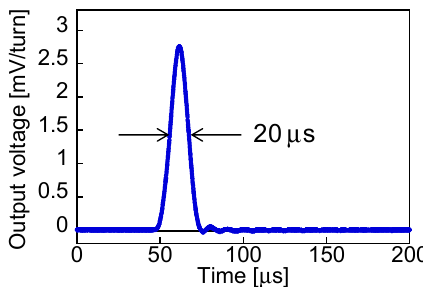
Figure 2. Example of a waveform of pulse voltage obtained from the Wiegand sensor.